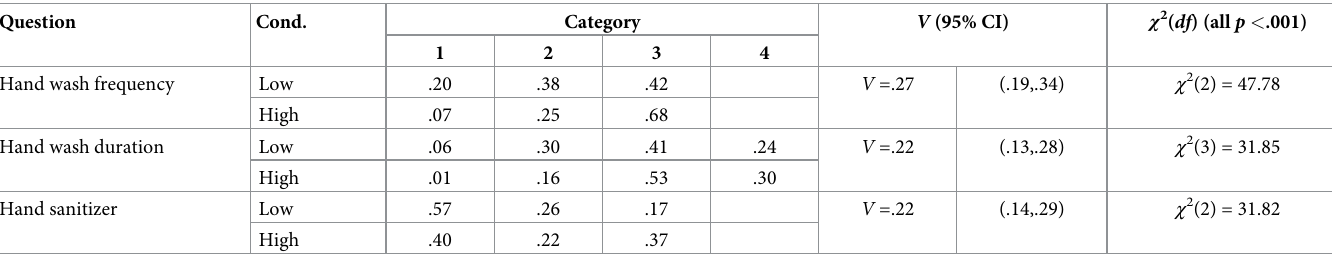
Table 6. Statistics comparing the recoded responses for the three behavior questions by condition. Question